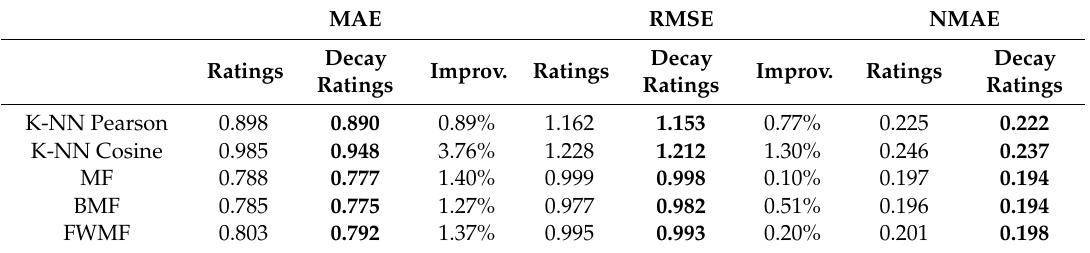
Table 2. The RMSE, MAE and NMAE values obtained for the rating prediction in the cold-start scenario. MAE RMSE NMAE Decay Decay Decay Ratings Improv. Ratings Improv. Ratings Ratings Ratings Ratings K-NN